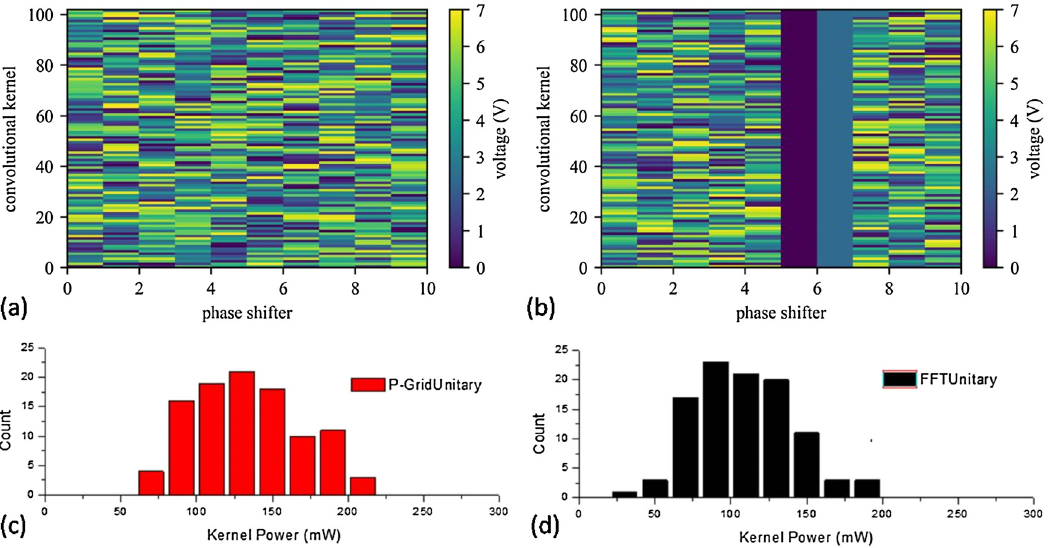
Figure 7: Voltage setting to configure the 102 kernels in the two convolutional layer of LeNet-5 model based on (a) pseudo-real-value P-GridUnitary meshand (b)FFTUnitary mesh.Powerconsumed duringconfiguringthe kernelbypseudo-real-value(a) P-GridUnitary meshand (b) FFTUnitary mesh.